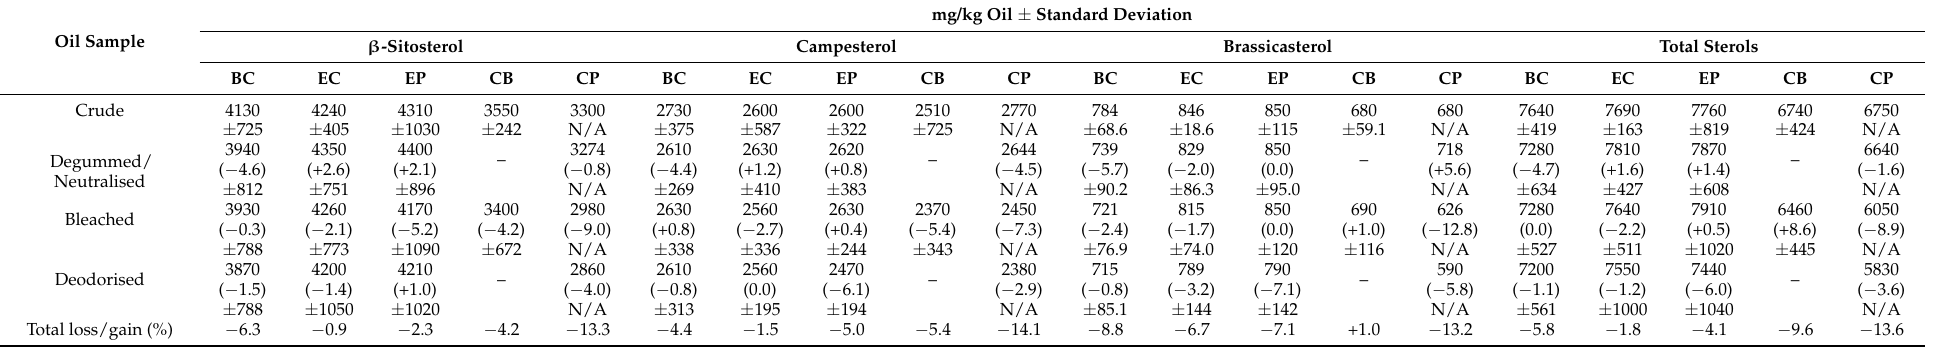
Table 3. Concentration of total (free + esterified) phytosterol (mg/kg oil ± standard deviation). Cumulative percentage gain/loss relative to the previous process is represented in brackets under concentrations for refining methods. Total loss/gain is reported in the bottom row and represents the total loss or gain of bioactive compound from crude oil to the deodorisation